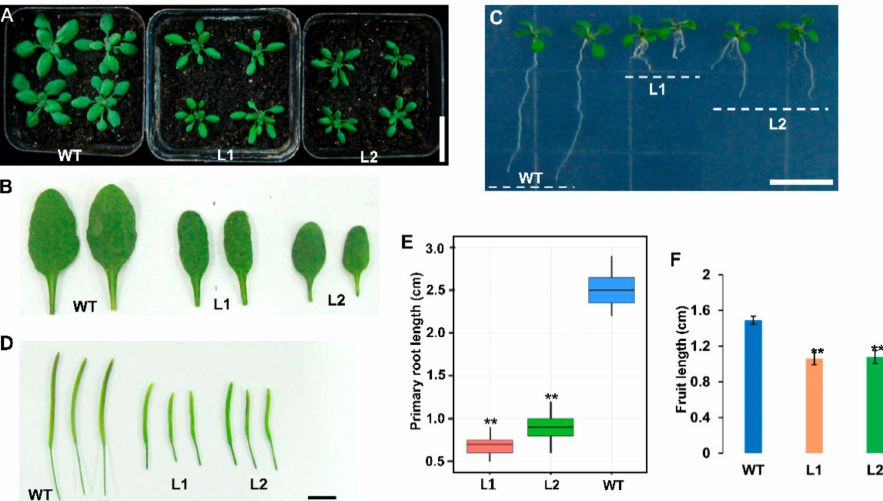
Figure 6. Overexpression of TaCLE3d in Arabidopsis . ( A , B ) The seedling ( A ) and corresponding leaves ( B ) at 19 d after germination. ( C ) The seedling at 10 d after germination. (D) The fruits from the plants at 35 d after germination. ( E – F ) Quantification of the primary root length of the seedling of TaCLE3d-OE ( n = 10) ( E ), and fruit length ( n = 18) ( F ). The bar graphs indicate the mean ± SE. Statistical significance (Student’s t -test) compared with wild Arabidopsis (WT) is indicated: ** p < 0.01. Scale bars: 2 cm in ( A ), 1 cm in ( C ), and 0.5 cm in ( D